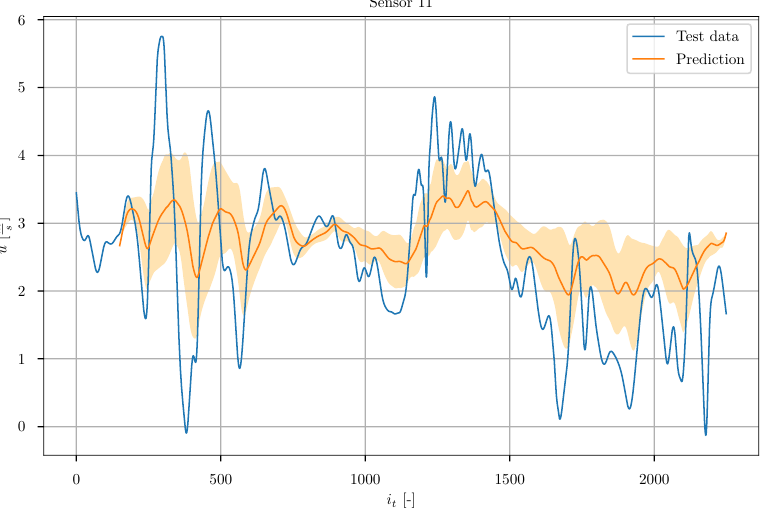
Figure 38. Averaged predicted timeseries and true timeseries of sensor 11 for the standard setup.